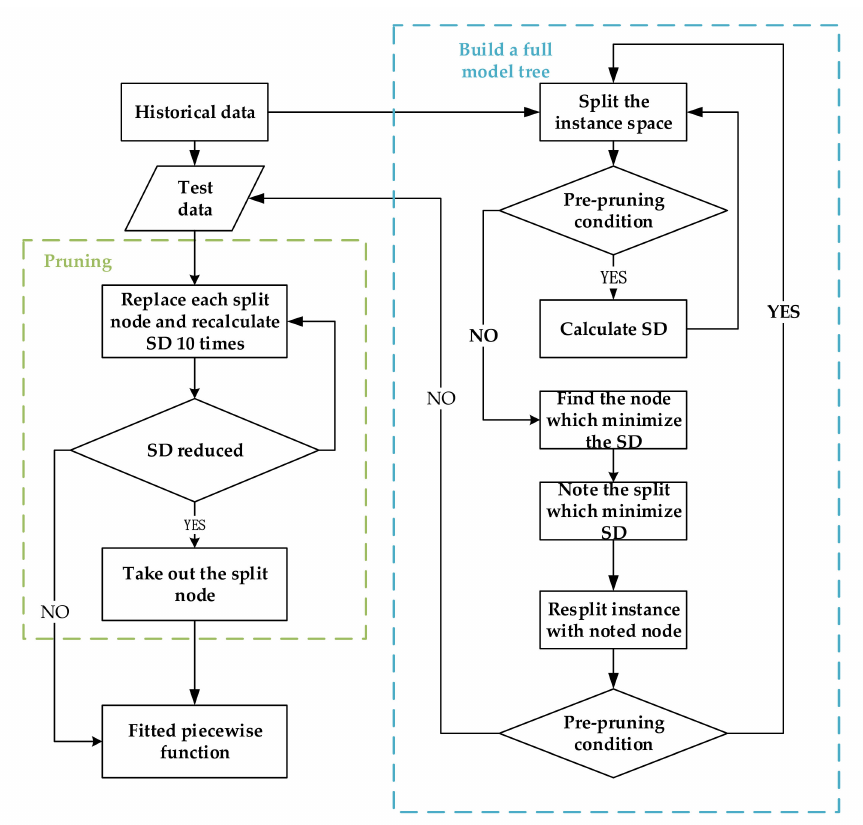
Figure 2. The model tree